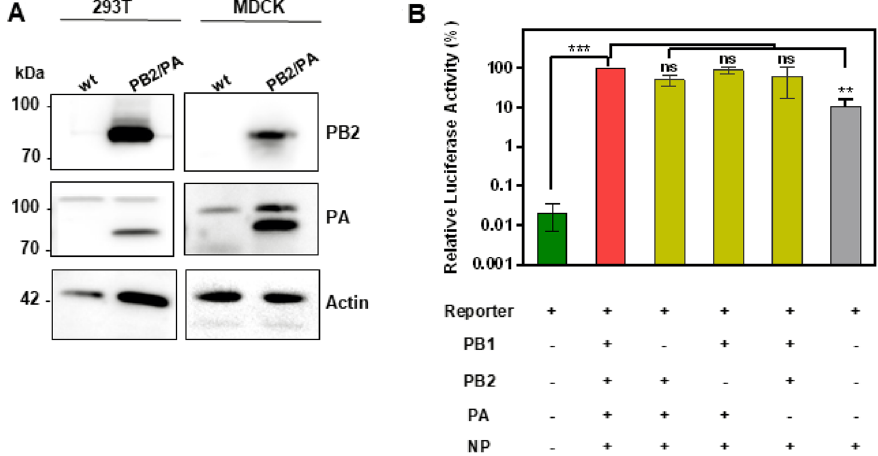
Figure 1. Characterization of MDCK and 293 T cells stably expressing IAV polymerase proteins. ( A ) Expression of PB2 and PA in MDCK and 293 T cells was analyzed by immunoblot. Detection of β-actin served as a loading control. Lysates from MDCK WT/MDCK PB2/PA and 293 T WT/293 T PB1/PB2/PA cells were loaded on three gels. Blots were exposed for 50 s for detection of PB2 in 293 T cells and for 30 s for detection in MDCK cells while exposure of 50 s was required for detection of β-actin. The exposure for detection of PA in 293 T and MDCK cells was 50 s and 10 s, respectively. ( B ) 293 T cells stably expressing PB2, PB1, and PA were transiently co-transfected with the indicated combinations of plasmids encoding PB2, PB1, PA and NP and an IAV luciferase reporter segment. Luciferase activities in cell lysates were determined at 24 h post transfection. Luciferase activity measured for cells co-transfected with all plasmids was set as 100%. The average of three independent experiments is shown. Error bars indicate SEM. Two tailed paired student t-test was used to